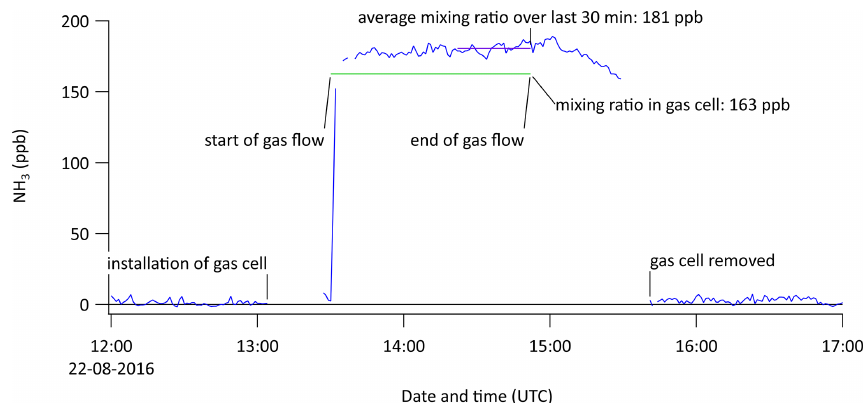
Figure 14. Concentration measurements with the miniDOAS #2 on 22 August 2016 before, during, and after the gas standard comparison